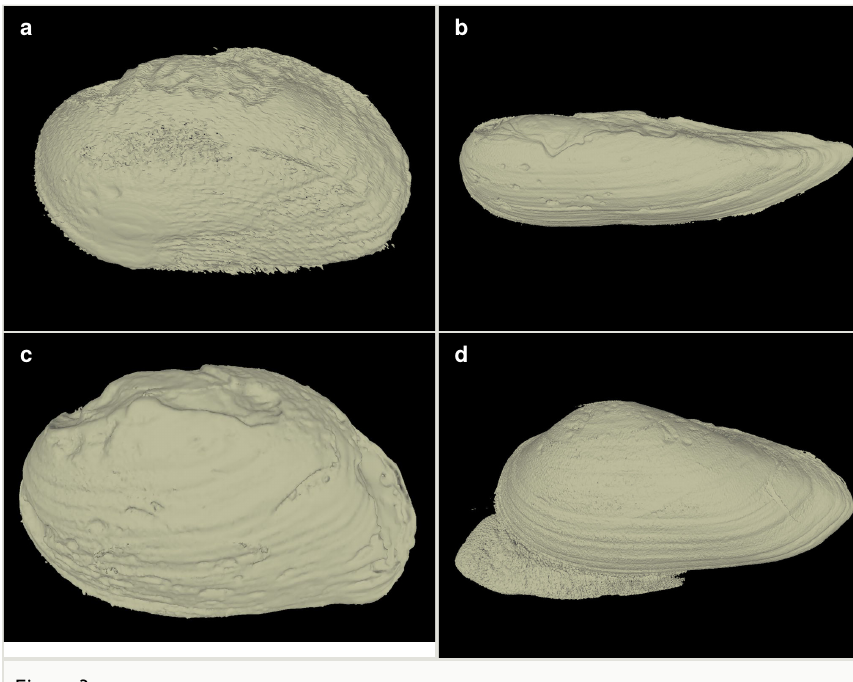
Figure 3. 3D surface models of freshwater mussels. a : Inversiunio yanagawensis (QUYK-06858) with "metal artifacts" noise due to the thick/hard shell. b : Lanceolaria grayana (QUYK-08773d). c : Pronodularia japanensis (QUYK-08881). d : Nodularia douglasiae nipponensis (QUYK-08667d).